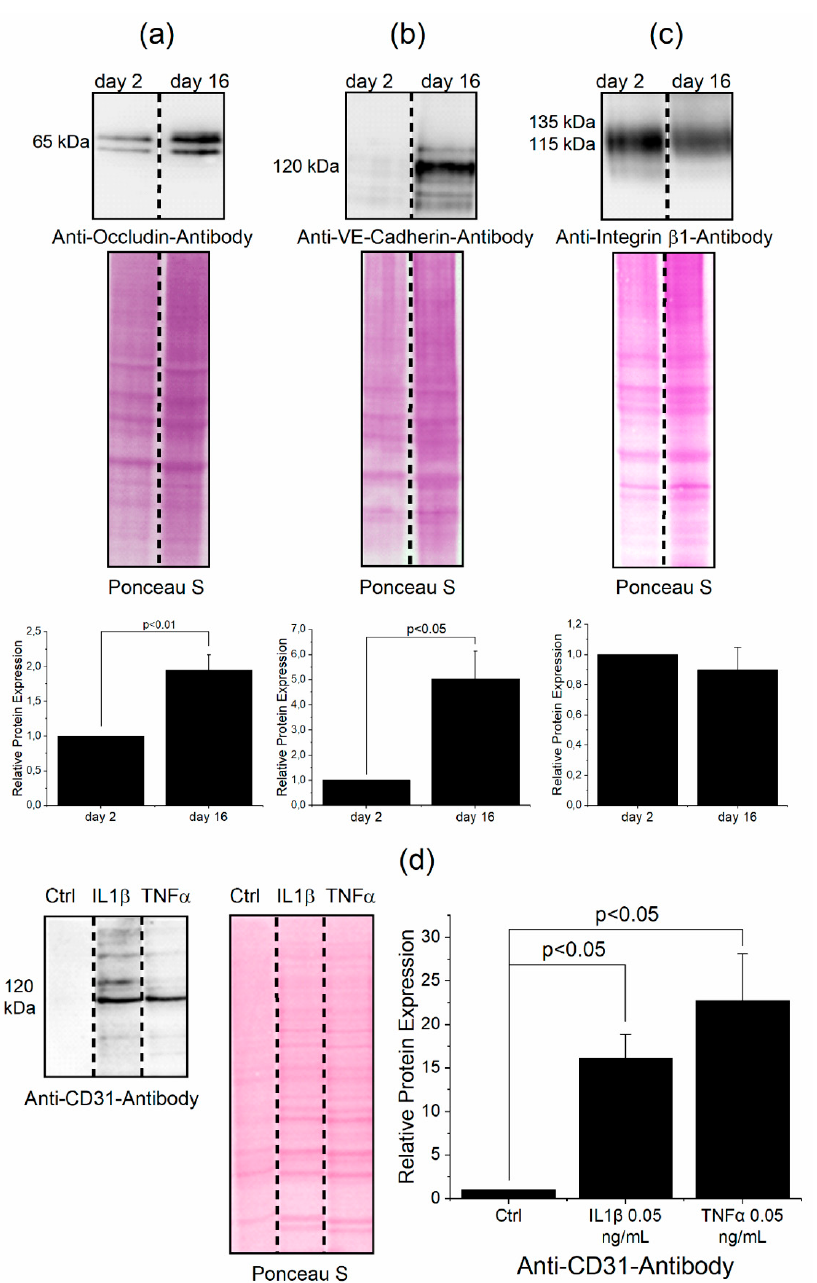
Figure 1. Determination of protein levels building the cell junctions in THMBECs. THBMECs were cultivated for 2 and 16 days. Afterwards, total protein was isolated and separated using SDS-PAGE. Expression of proteins was detected via immuno-blotting using anti-occludin antibody ( a ), anti-VE-cadherin antibody ( b ) and anti-integrin β 1 antibody ( c ), respectively ( n = 3). THBMECs were incubated with IL1 β and TNF α at a concentration of 0.05 ng/mL for 24 h. Total protein was isolated and separated using SDS-PAGE. Expression of CD31 was detected by immuno-blotting using anti-CD31 antibody ( d ), ( n = 3).